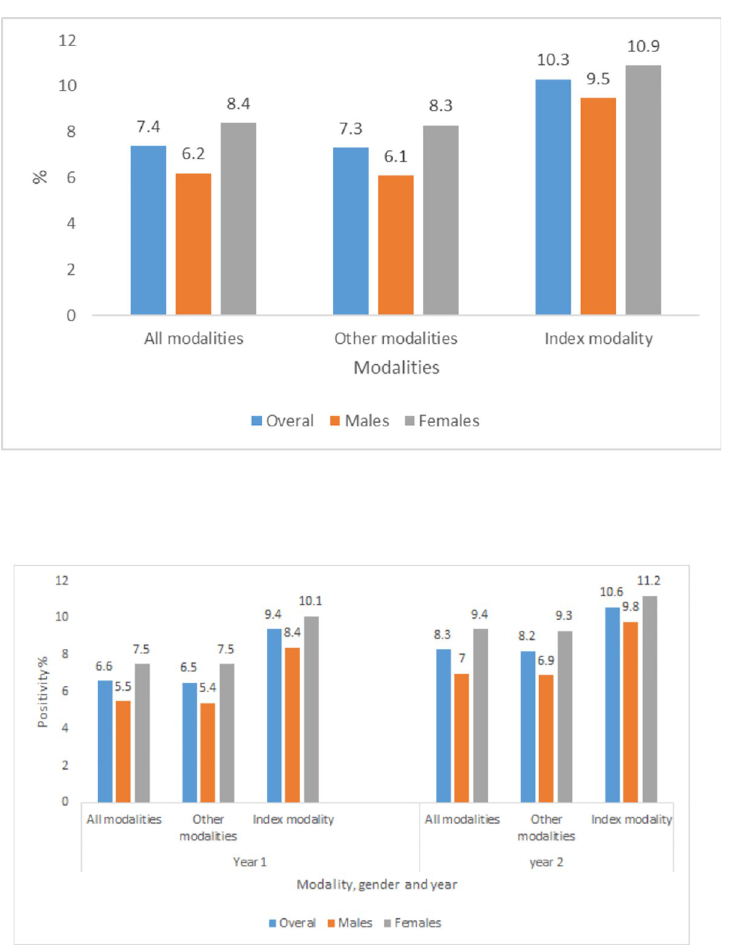
Fig 3. a. HIV positivity by modality, and b. HIV positivity by modality, gender and